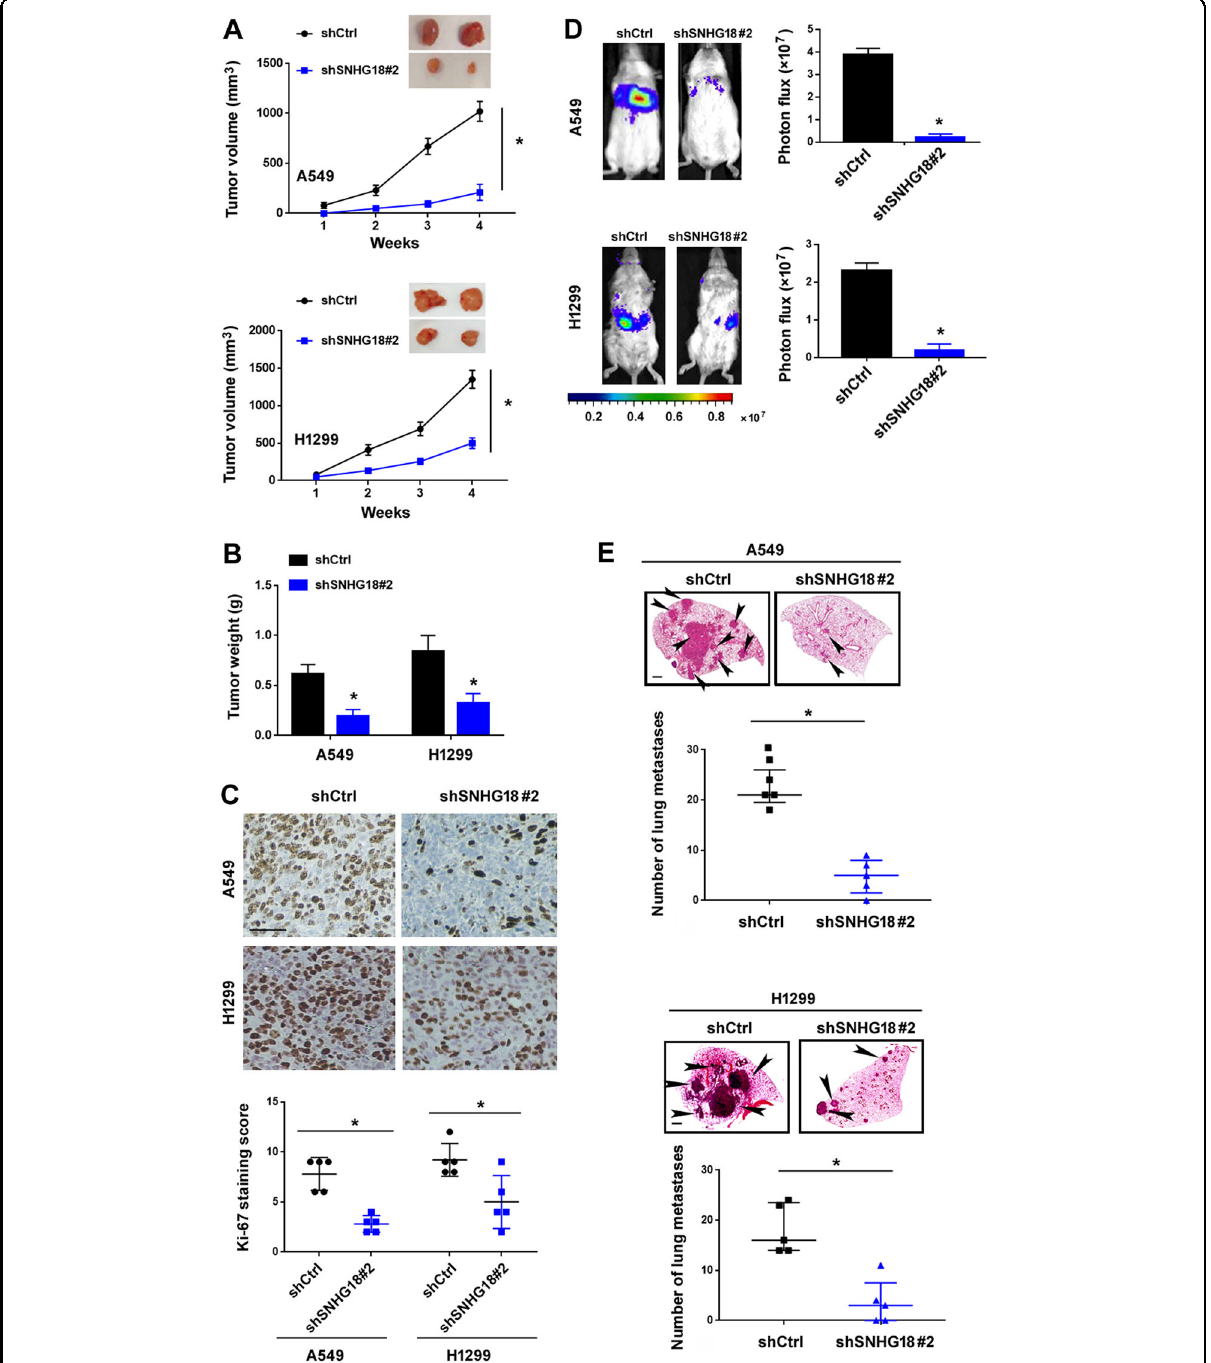
Fig. 4 SNHG18 depletion restrains tumorigenesis and metastasis of NSCLC cells in vivo. A NSCLC cells with SNHG18 depletion were subcutaneously implanted to nude mice, and tumor growth was examined. Top, representative subcutaneous xenograft tumors from 2 mice of each group are shown. n = 5. B Tumor weight was measured 4 weeks after NSCLC cell implantation. n = 5. C Ki-67 immunostaining in tumor sections. Top , representative images of ki-67 staining. Scale bar = 100 μ m. Bottom panels show ki-67 staining scores. n = 5. D In vivo bioluminescence imaging showed that knockdown of SNHG18 reduced the metastatic capacity of A549 and H1299 cells. Left, representative bioluminescent imaging of mice injected with luciferase-labeled A549 and H1299 cells. n = 5. E H&E-stained sections of the lung tissue collected from nude mice injected with SNHG1-depleted A549 and H1299 cells. Arrowheads indicate metastatic lesions in the lung. Bottom, quanti fi cation of metastatic lesions from 5 mice is shown. Scale bar = 100 μ m. * P < 0.05 vs. shCtrl. In all panels, Student ’ s t -tests were performed. n =